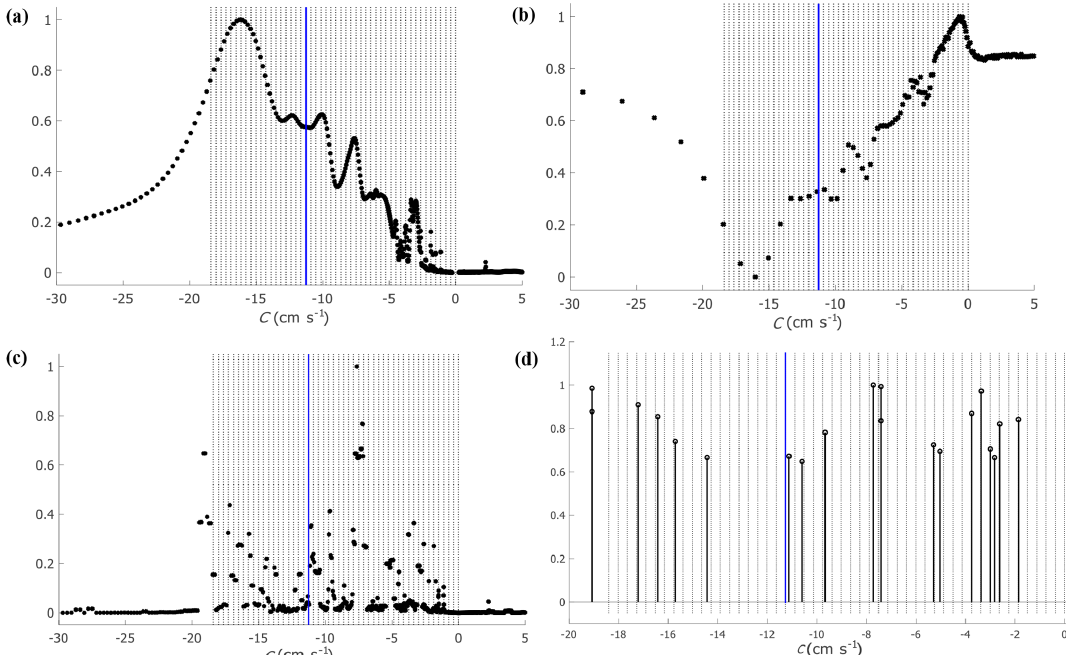
Figure 2. An application of the four methods to the artificially generated signal shown in Fig. 1a (panel a : Radon transform, panel b : variance, panel c : 2-D FFT sweeping, panel d : 2-D FFT maximal amplitude). Blue lines correspond to the dominant input mode propagation speed and dashed black lines correspond to the input modes’ propagation